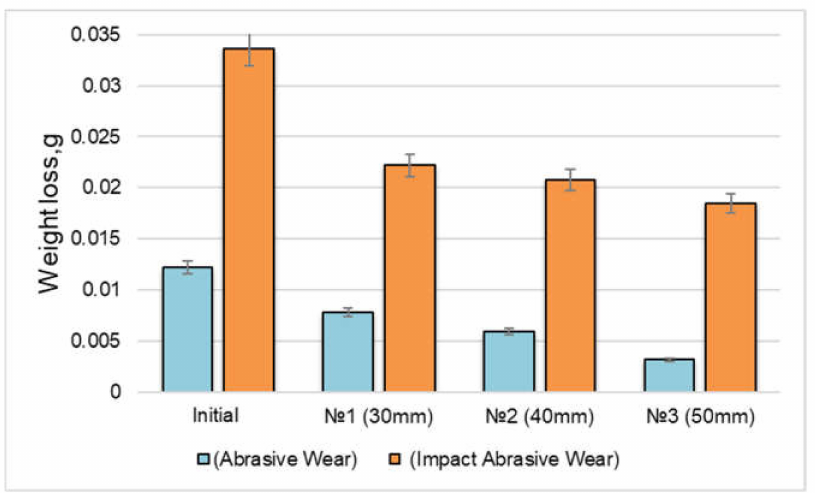
Figure 10. Results of testing abrasive and shock-abrasive wear before (initial) and after pulsed-plasma treatment, depending on the distance from the